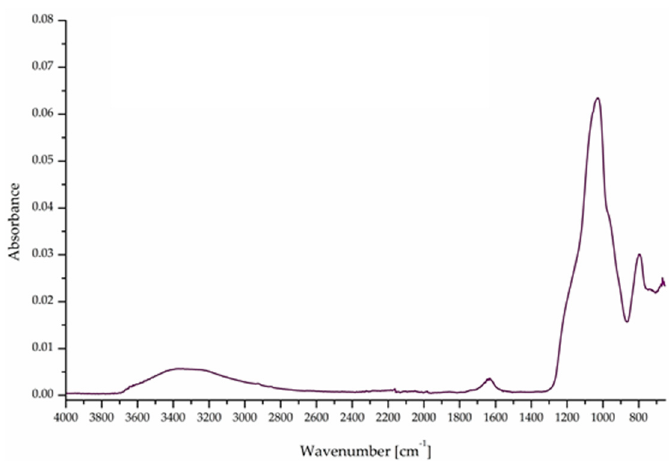
Figure 2. FTIR-ATR spectra of the thermogravimetric analysis (TGA) residue of BOMF/MNA_2Si in air.